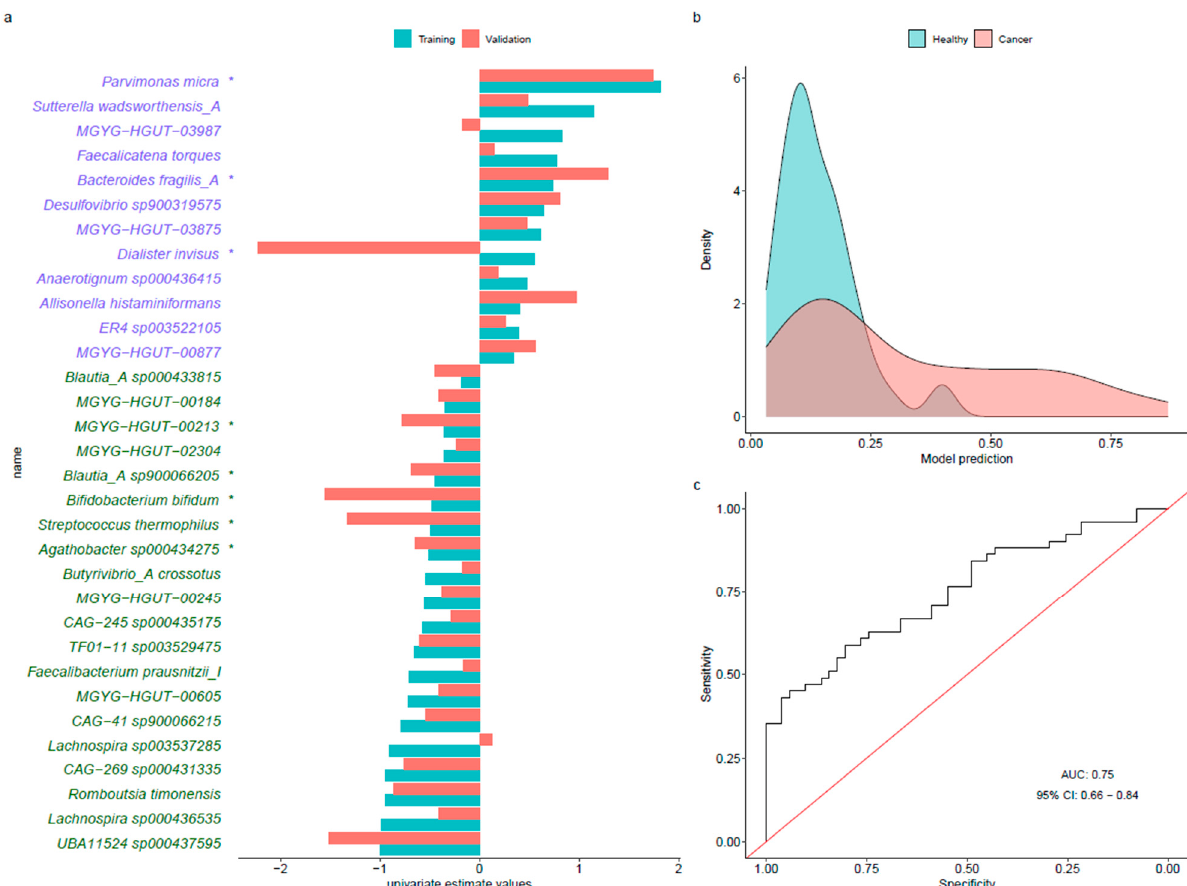
Figure 3. Summary of the LASSO predictive model in our dataset. ( a ) Training (blue) and validation (red) estimate values for each control-enriched (green) and cancer-enriched (purple) species selected by the model. ( b ) Density plot of model prediction, colored by the status of the samples. ( c ) Receiver operating characteristic curve representing the performance of the model. *: statistically significant ( p -value < 0.05) based on Wilcoxon rank sum test in aldex.ttest .